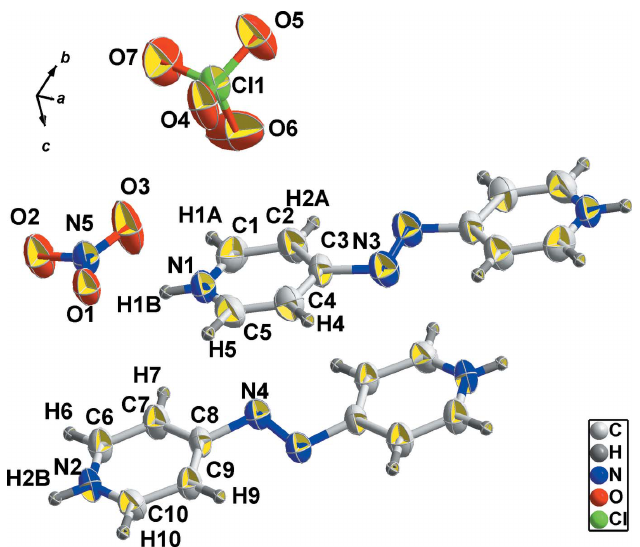
Figure 1 The structure of the title compound showing the asymmetric unit (labelled) with cations supplemented by the symmetry-generated moieties (not labelled) at 1 (cid:3) x , 2 (cid:3) y , 2 (cid:3) z (molecule containing N1/ N3) and at 1 (cid:3) x , 1 (cid:3) y , 2 (cid:3) z (molecule containing N2/N4). Displacement ellipsoids are drawn at the 50% probability